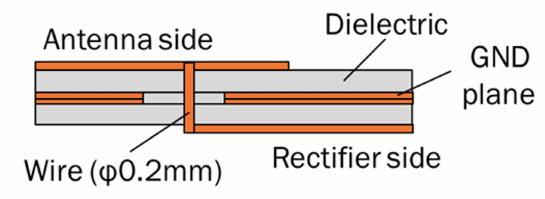
Figure 9. 28 GHz back feed structure of antenna and rectifier.